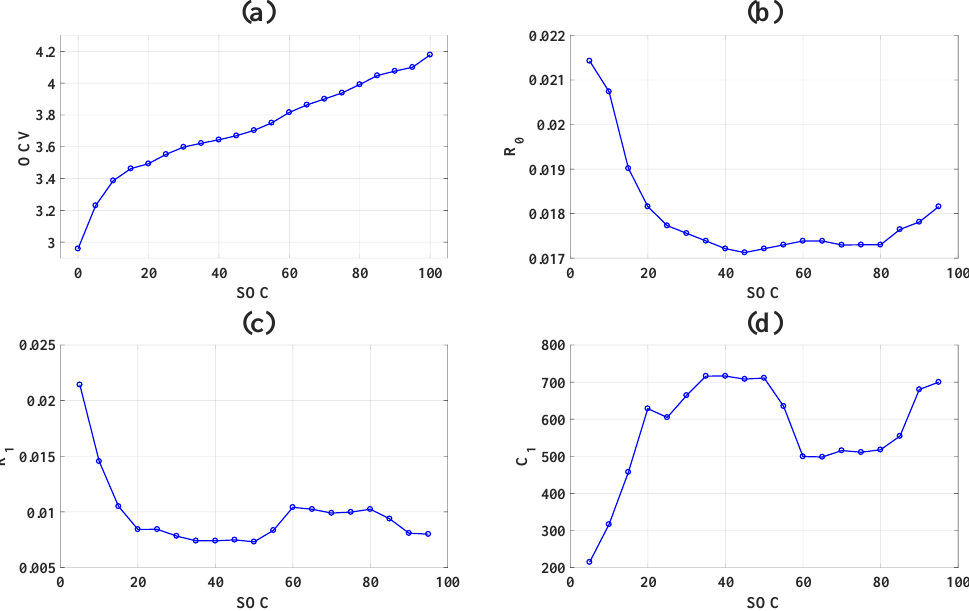
Figure 6. Resulting equivalent parameters: ( a ) SOC-OCV relationship, ( b ) internal resistance ( c ) resistance value of RC-pair and ( d ) capacitance value of RC-pair. The equivalent parameters are obtained based on the method presented by Kim et al. [44].